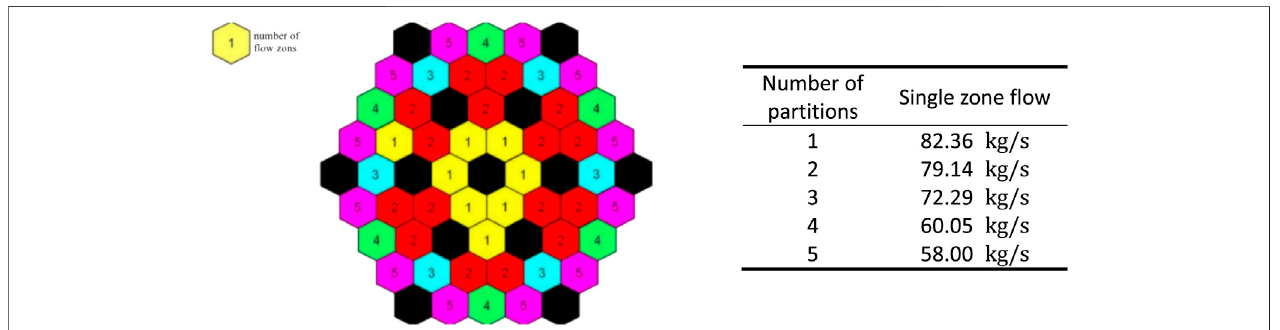
FIGURE 9 | SPALLER-100 fi nal partition scheme.